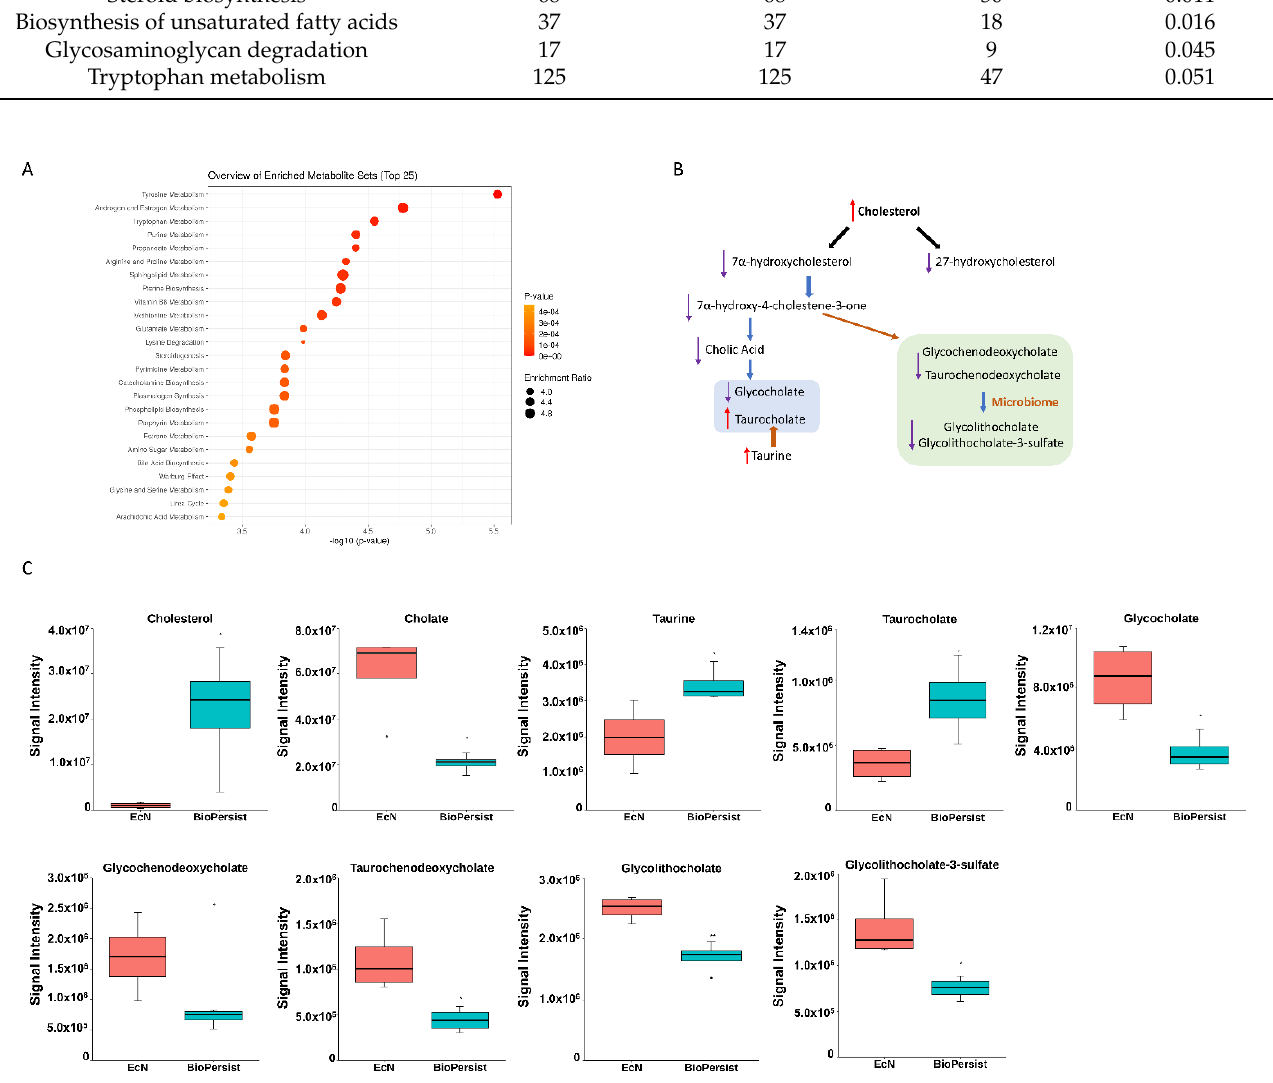
Figure 2. BioPersist decreases the accumulation of bile acids in the colon. ( A ) The top 25 pathways calculated with pathway analysis on MetaboAnalyst. ( B ) Summary of bile acid biosynthesis. Conjugated bile acids are highlighted in blue and secondary bile acids in green. ( C ) Individual metabolites involved in the bile acid biosynthesis pathway. n = 4 per group. * p < 0.05.